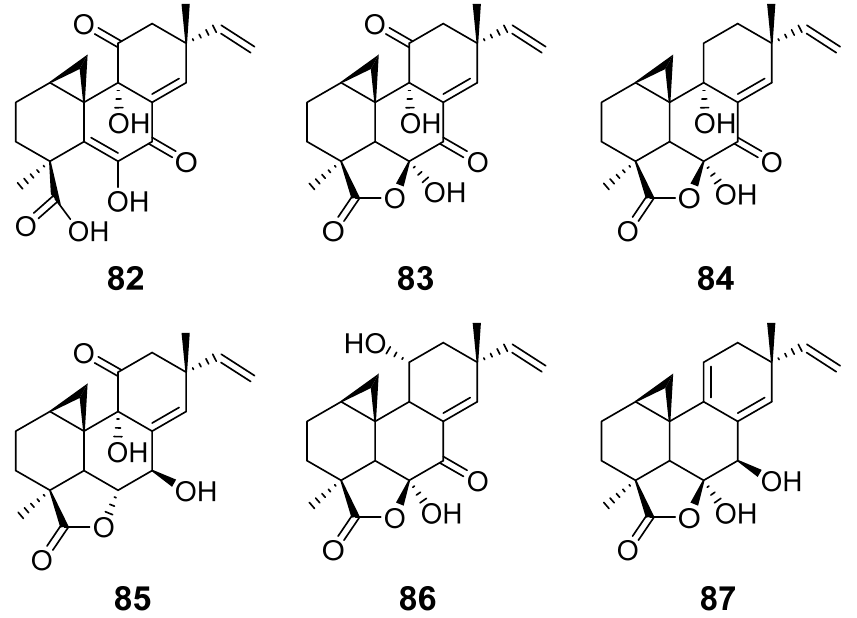
Figure 8. Structures of compounds 82 – 87 .